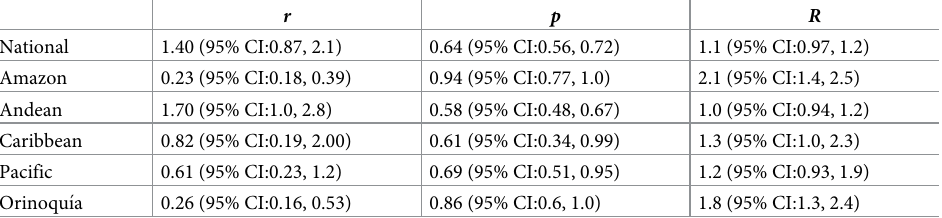
Table 5. Estimates of reproduction number ( R ), growth rate parameter (r ) and deceleration of the growth param- eter ( p ) obtained from the renewal equation method utilizing the GGM for the early ascending phase of the epi- demic (30 days) at the national and regional level at α = 1.00.